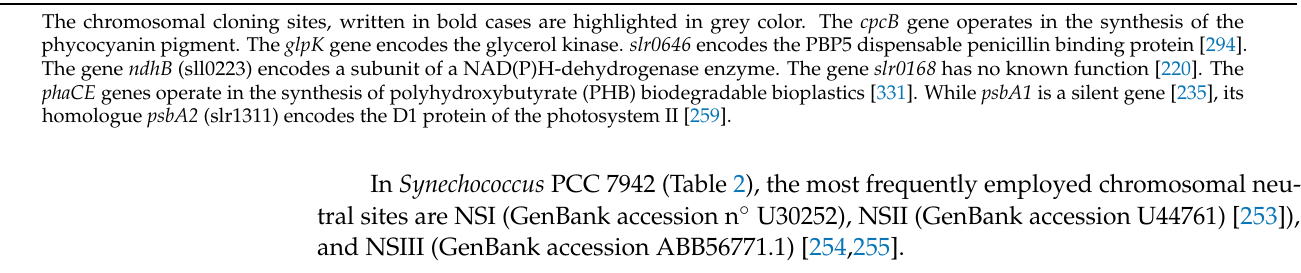
Table 2. Literature on the utilization of neutral chromosomal cloning sites in Synechococcus PCC 7942. Neutral Site and Objective of the Gene